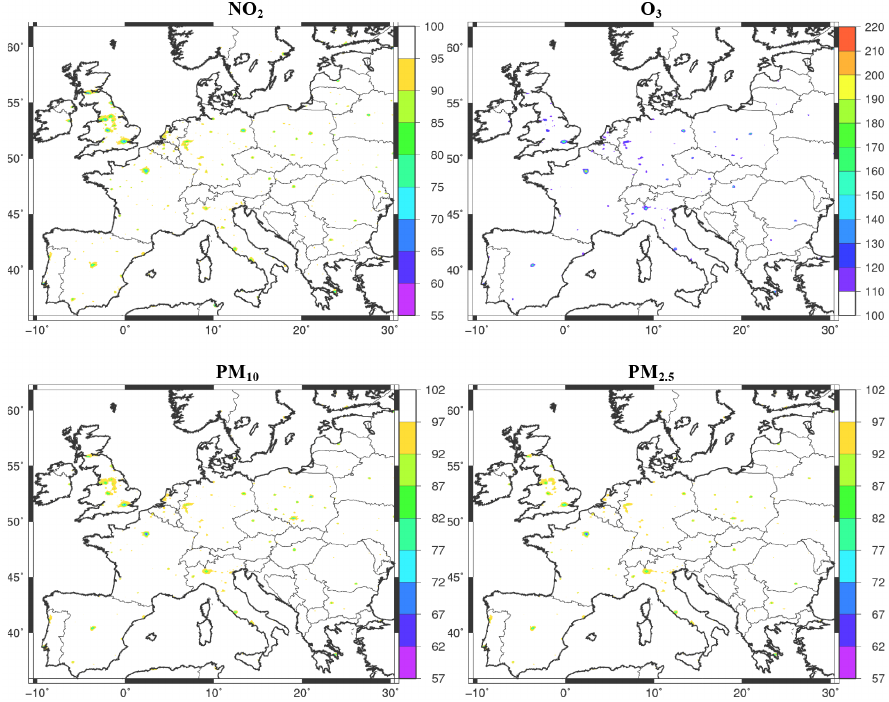
Figure 2. Concentration from the simulation without the urban correction normalized by the simulation including the urban correction (in %) for NO 2 , O 3 , PM 10 and PM 2 . 5